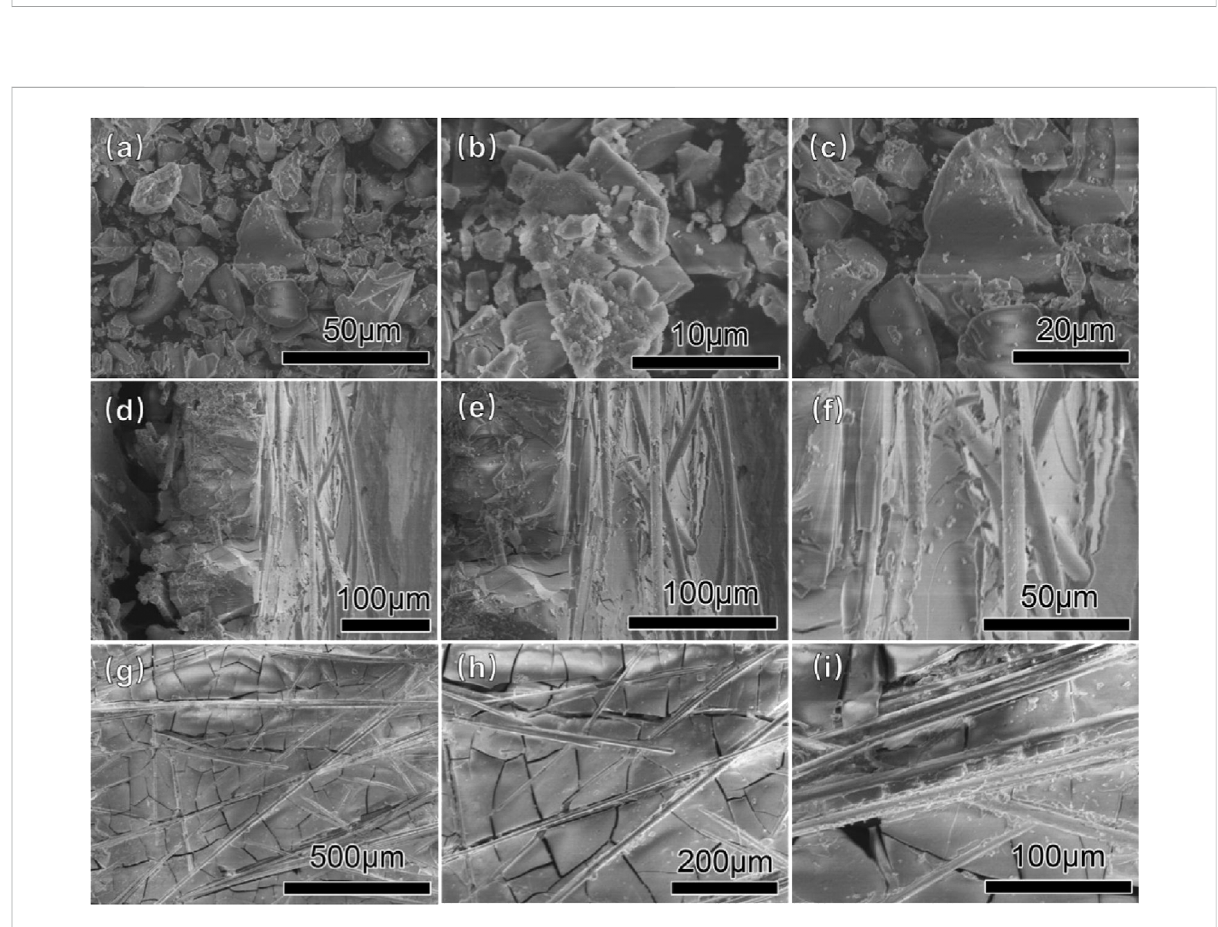
FIGURE 2 Typical SEM images of the as-obtained honeycomb silica gel with CO 2 as the neutralized agent. (A – C) Silica gel powder detached from the honeycomb matrix; (D – F) cross section of honeycomb matrix; and (G – I) surface of the honeycomb